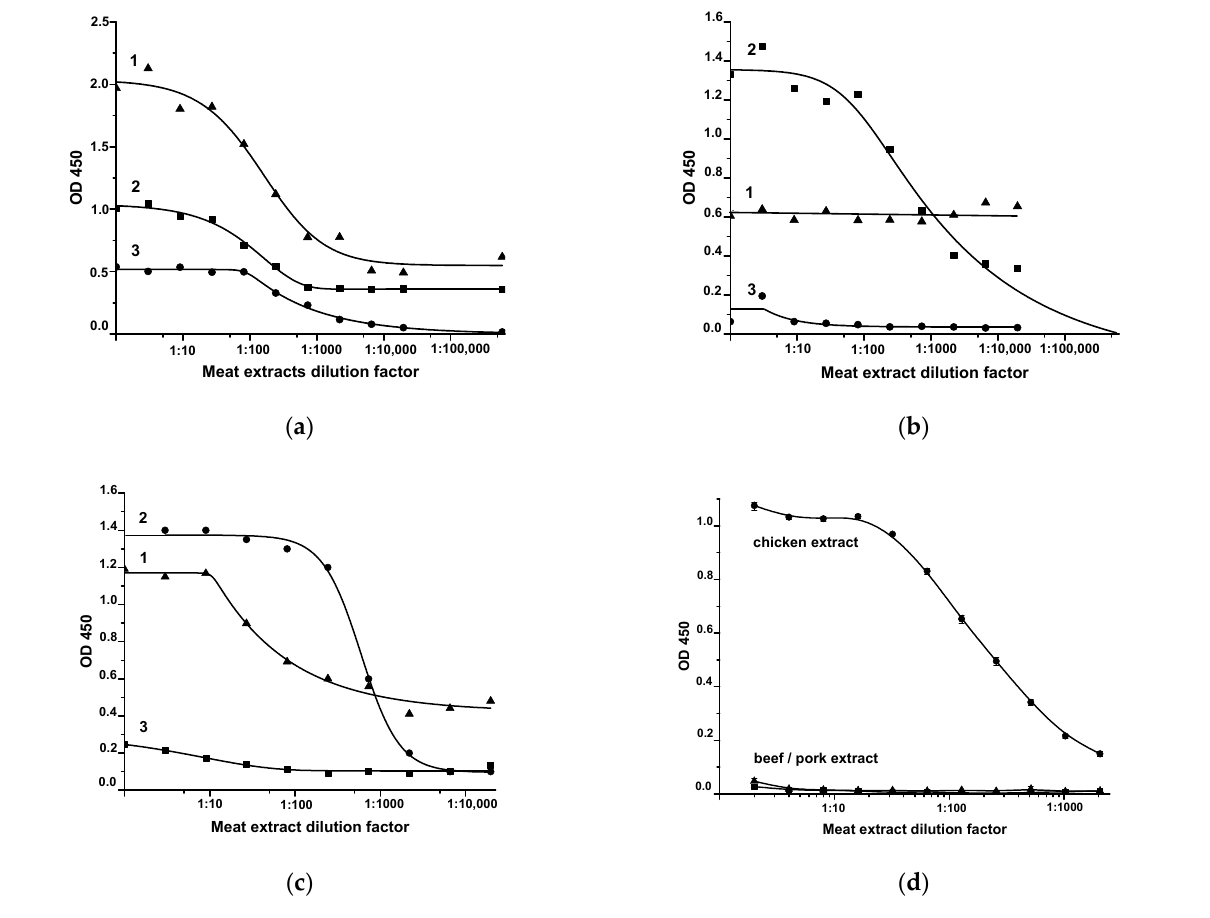
Figure 1. Sandwich ELISA of TnI ( a – c ) and IgY ( d ) using different combinations of immunoreac- tants. On x axis—dilution of tested meat extracts, on y axis—registered optical density at 450 nm in microplate wells ( n = 3) reflecting formation of sandwich immune complexes [immobilized antibody—antigen—biotinylated antibody—streptavidin-peroxidase]. ( a )—immobilized MAb 7G2, ( b )—immobilized MAb 6F9, ( c )—immobilized MAb C5. 1—MAb C5-biotin; 2—Mab 7G2-biotin; 3—Mab 6F9-biotin.